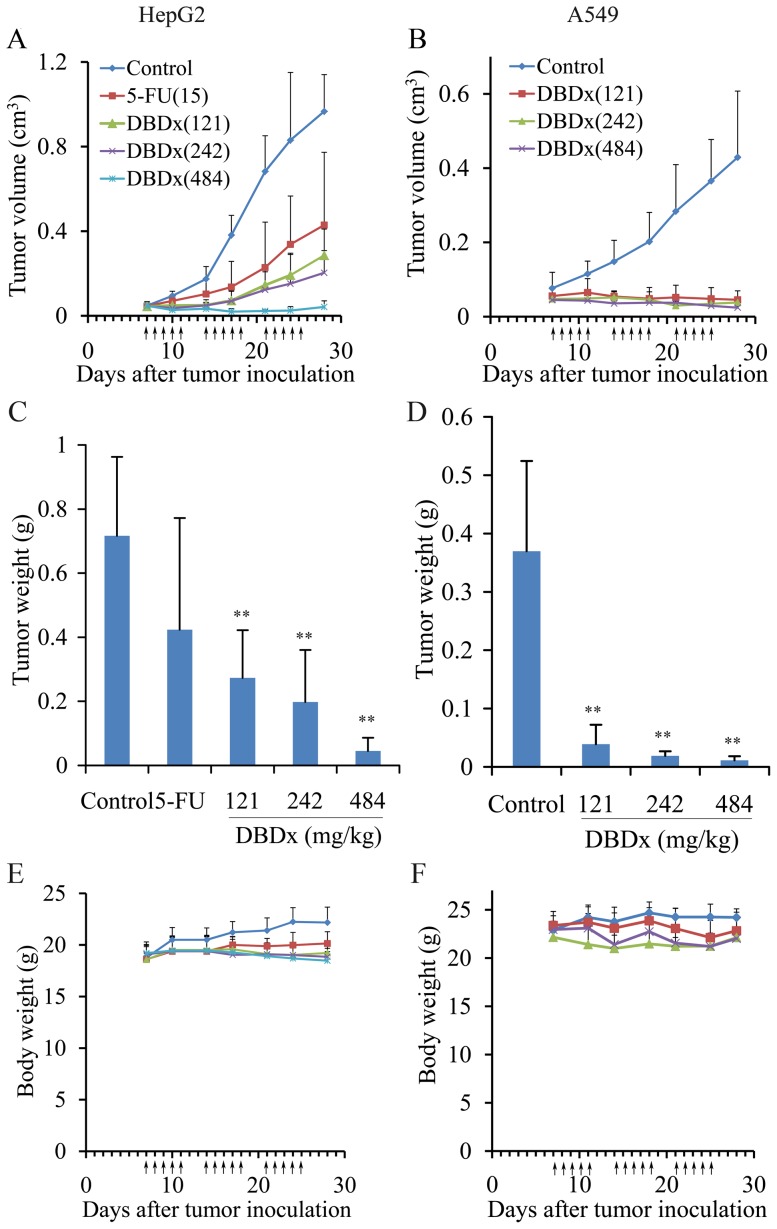
DBDx inhibited the growth of HepG2 xenograft and A549 xenograft in athymic mice.
A,C and E. Tumor growth curve, tumor weight at the end of the experiment and the body weights of mice of all groups in HepG2 xenograft model. B, D and F. Tumor growth curve, tumor weight at the end of the experiment and the body weights of mice of all groups in A549 xenograft model. (Dose: mg/kg). Statistical significance was determined by Student's t-test; **P<0.01 compared with control.